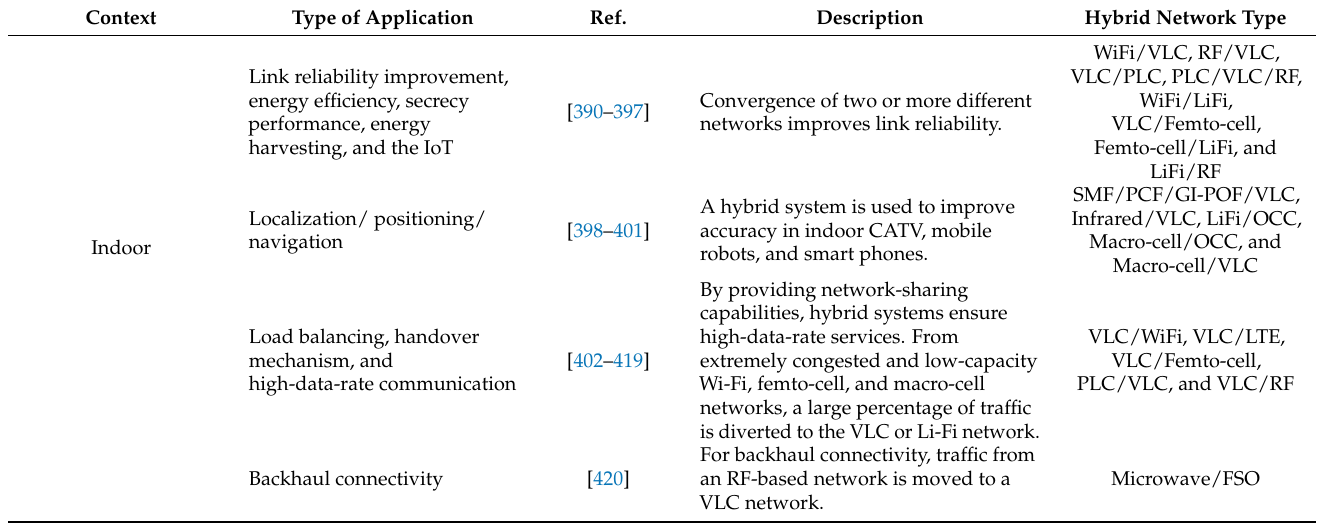
Table 2. Synopsis of hybrid and convergent systems with their applications.